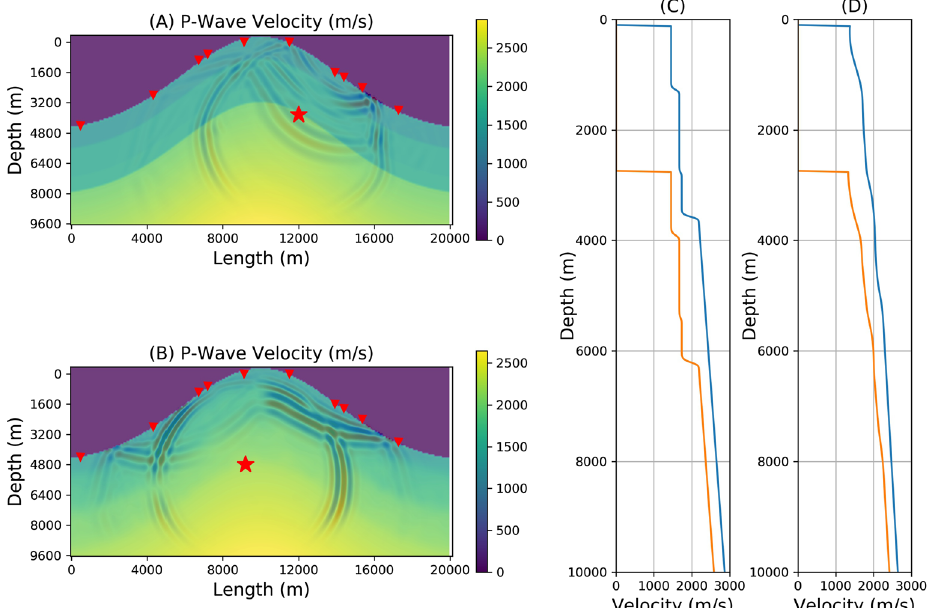
Figure 1. ( A ) A single p-wave velocity model drawn from population L which consists of 20,000 velocity models. The numerically simulated seismic wavefield using an elastic lattice wave propagation method is shown overlain on the models with the source location (shown by the *). ( B ) A single p-wave velocity model drawn from the population T which consists of 20,000 velocity models. The numerically simulated seismic wavefield is shown overlain on the models. ( C ) The velocity profile through the model shown in ( A ) from two different locations in this model. ( D ) The velocity profile through the model shown in ( B ) from two different locations in this model. The triangles in ( A ) and ( B ) show the location of the synthetic seismic stations at which time varying synthetic seismic data are ‘captured’ during the simulation